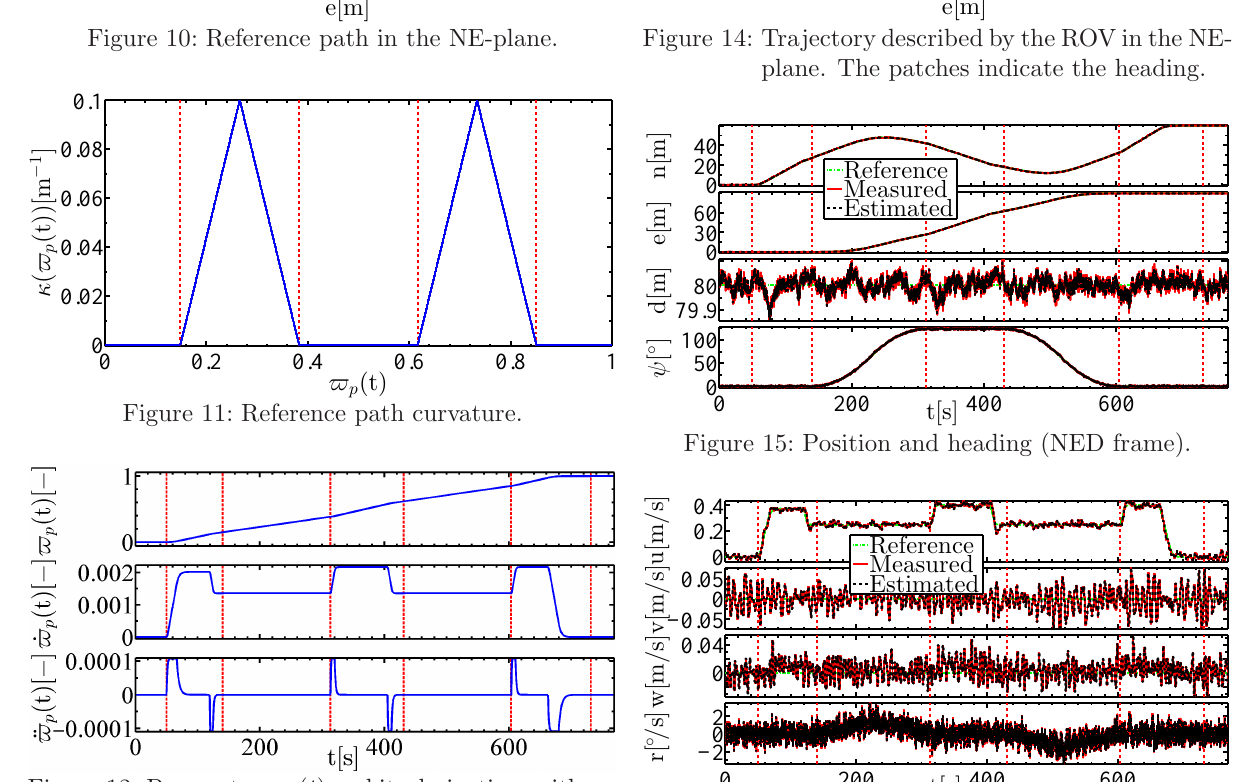
Figure 12: Parameter ̟ p ( t ) and its derivatives with re- spect to time ˙ ̟ p ( t ) and ¨ ̟ p ( t ).